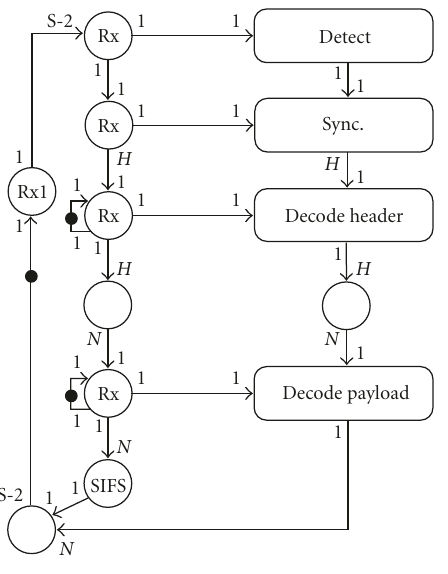
Figure 8: MRDF model of 902.1b (WLAN) reception